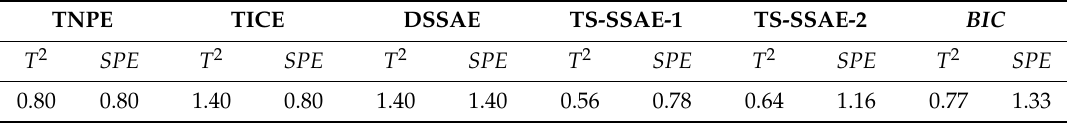
Table 1. Result of fault detection in the case study (FAR) / %.